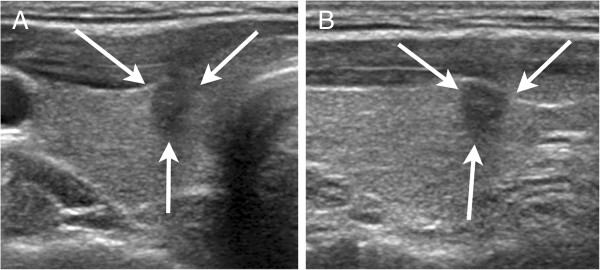
US findings of a malignant thyroid nodule in underlying homogenous thyroid echogenicity. (a) Transverse and (b) longitudinal US showed a 6-mm irregular, taller than wide nodule (arrows) with homogenous echogenicity of the underlying thyroid gland in the right thyroid gland. The lesion was diagnosed as papillary microcarcinoma on surgical histopathology.